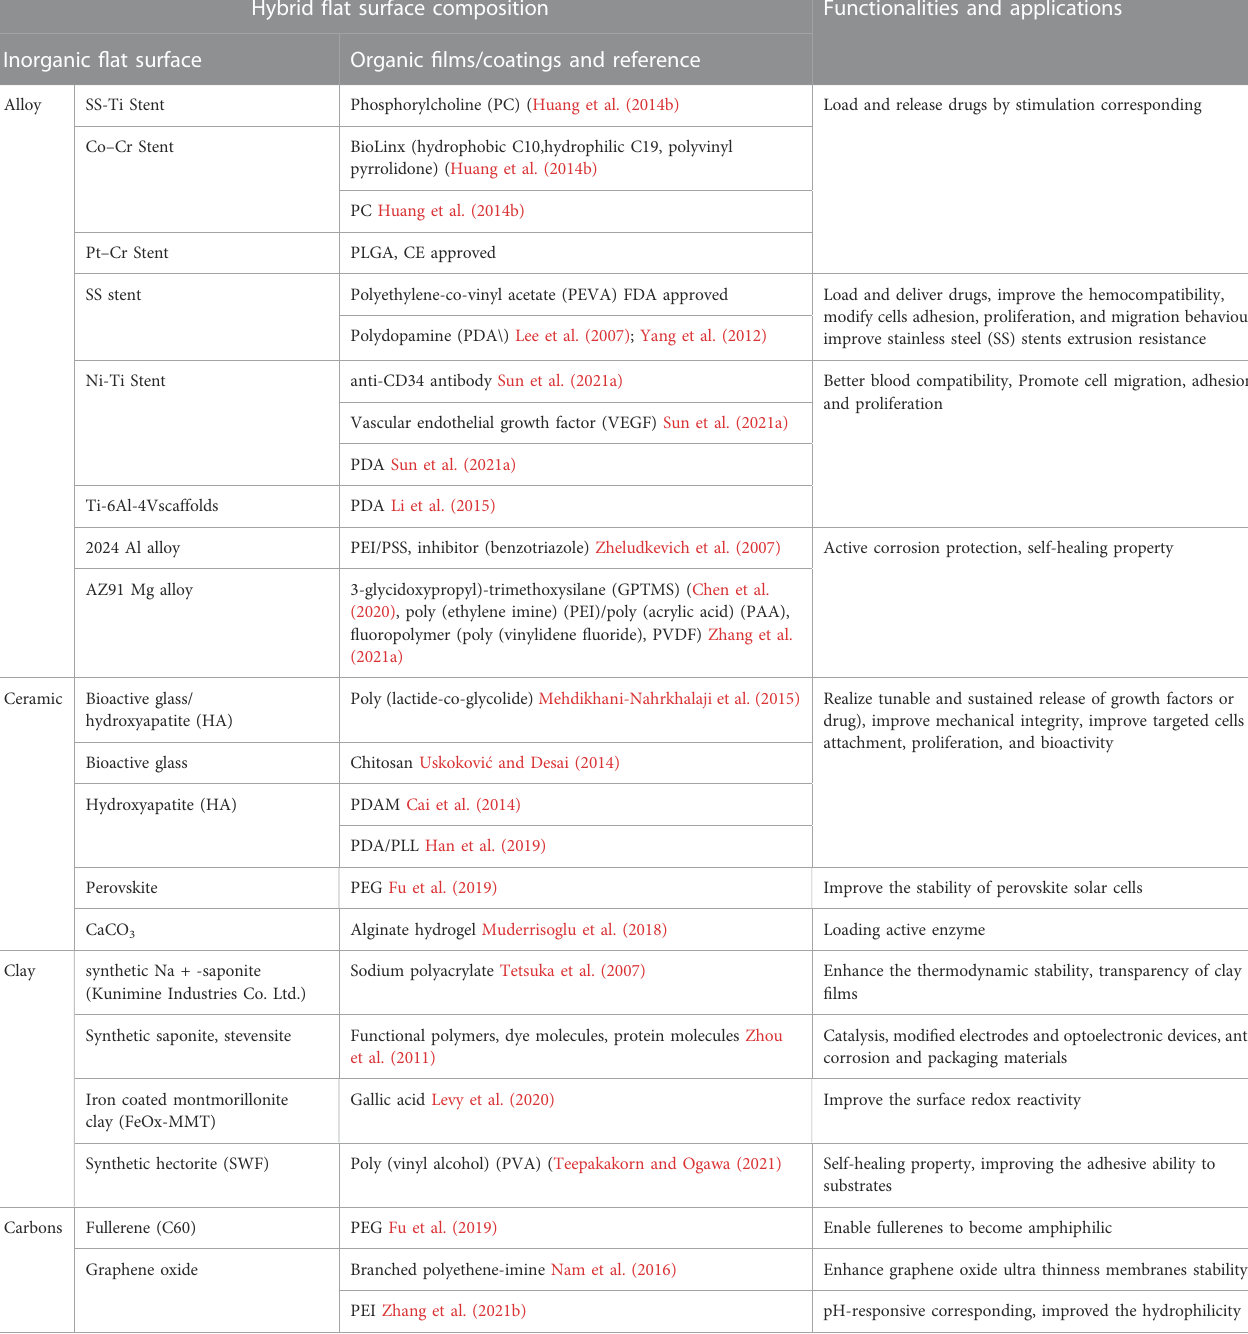
TABLE 3 Overview of hybrid organic fi lms/coatings on inorganic substrates/ fl at surfaces, their composition and functionalities. Hybrid fl at surface composition Functionalities and